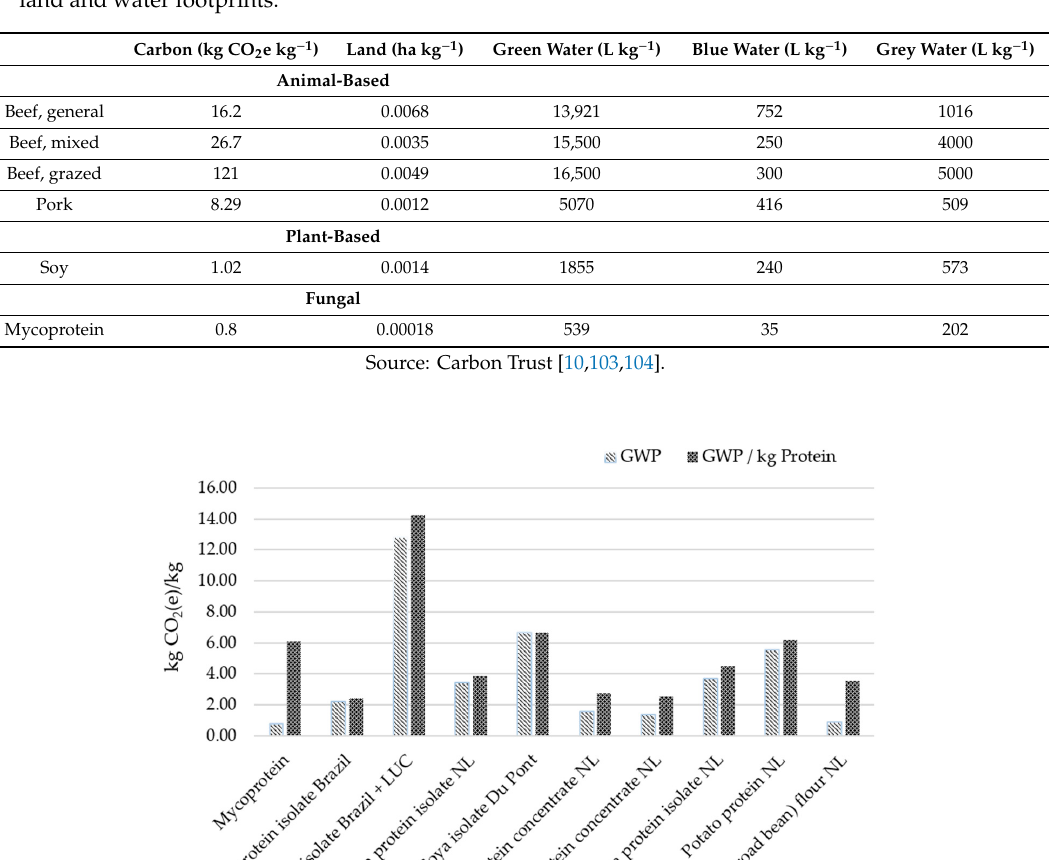
Table 4. Sustainability comparator of di ff erent protein sources—summary of the average carbon, land and water footprints.